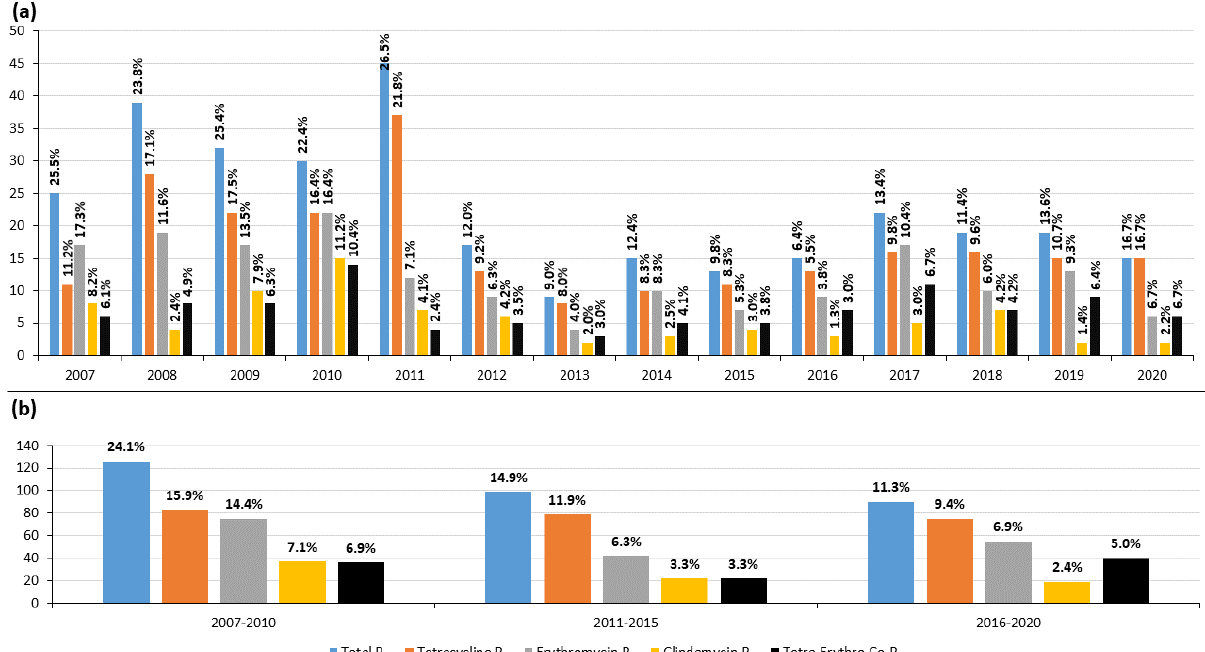
Figure 3. Change over time in antimicrobial resistance in Streptococcus pyogenes . Rates of tetracycline, erythromycin, and clindamycin resistance distributed ( a ) yearly and ( b ) by 4–5-year periods. R, resistance. Vertical axis = number of isolates. Total R represents the sum of the resistant isolates.